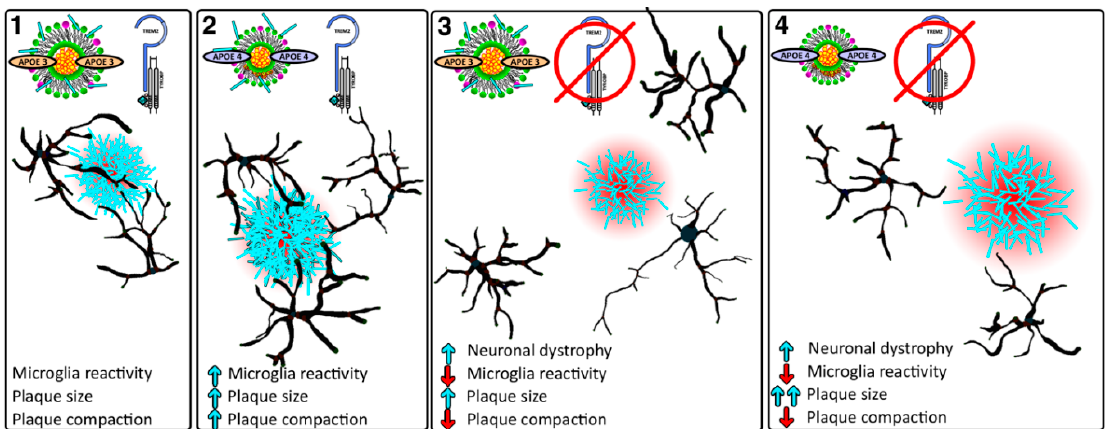
Figure 3. Schematic illustration of the relationship between APOE and TREM2. Microglia in black cluster around amyloid deposits, which impacts plaque morphology and the microenvironment surrounding the plaques. Boxes 1 and 2 illustrate TREM2 in an active state and show an increase in plaque size, compaction, and microglia reactivity in APOE4 compared to APOE3. Microglia which are TREM2 deficient (boxes 3 and 4) fail to contain the plaques allowing them to become more diffuse and increase the surrounding dystrophic area. Arrows are relative to APOE3, TREM2 active (box 1).